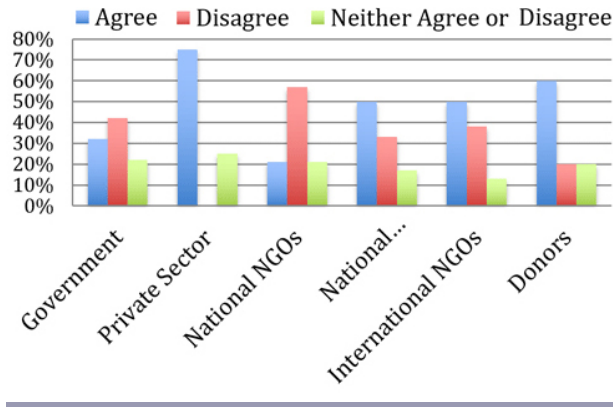
Fig. 2 . Responses to the statement that REDD+ projects will exacerbate conflicts over land and forest resources. Percentage measures by actors